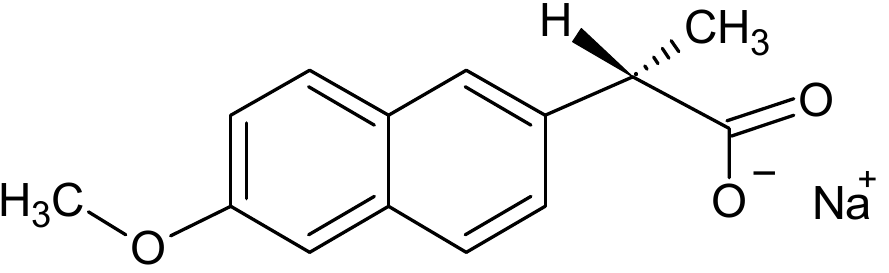
Figure 3. The structure of naproxen sodium.